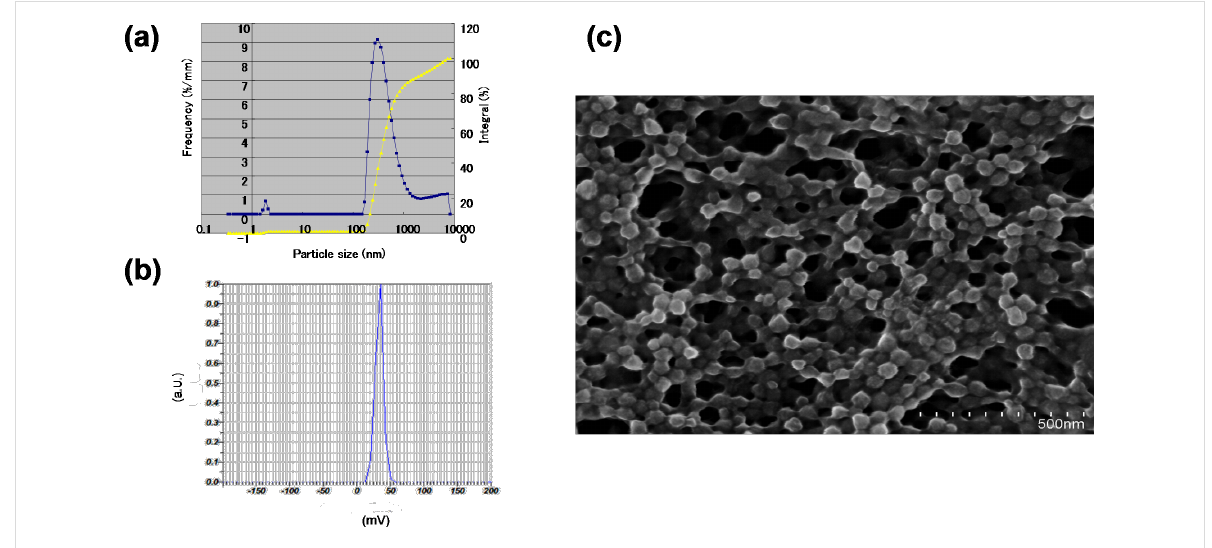
Figure 4: Characteristics of the DDMC–paclitaxel complex. (a) Particle size distribution and ζ -potential of the DDMC–paclitaxel complex determined by dynamic light scattering and (b) particle electrophoretic mobility measurements. (c) A Scanning electron microscopic image (HITACHI S-4800) of the freeze-dried DDMC–paclitaxel complex taken at an accelerating voltage of 5 kV. (a): Reprinted from